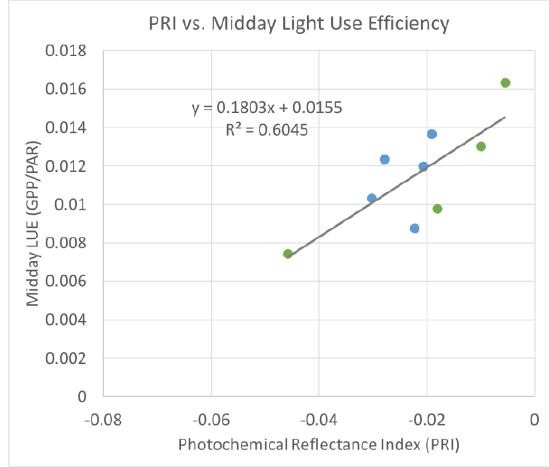
Figure 4 . PRI from DESIS compared with midday photosynthetic light use efficiency (GPP/incident PAR) from flux towers for summertime deciduous site observations. Blue points are for US-xUN, and green points are for US-Ha1 observations.